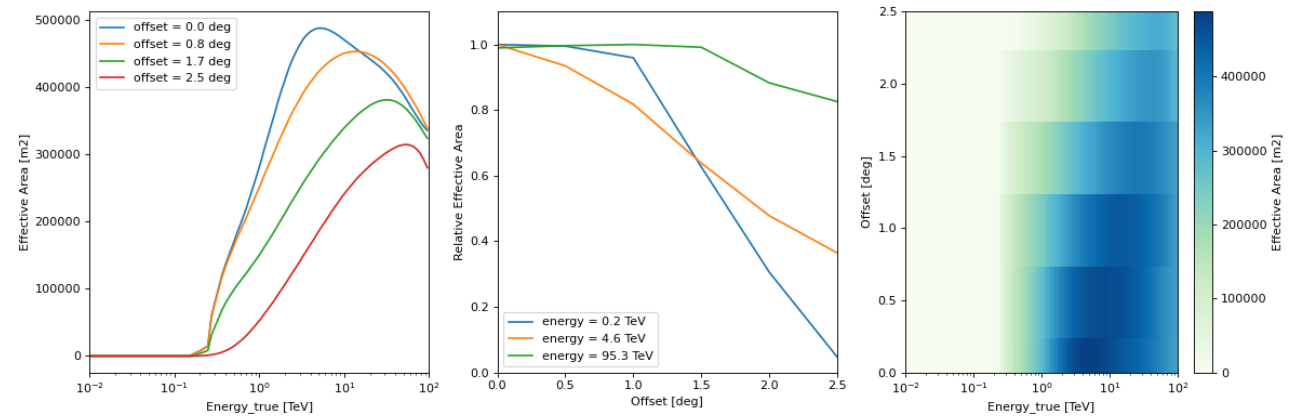
Figure 4. Example of visualisation of the effective area of a IACT and its dependency on energy and offset angle. The IRF component is read from DL3 files and displayed using Gammapy .